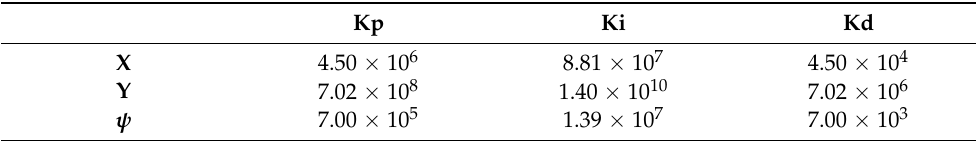
Table 2. Nonlinear Proportional Integral derivative (PID) control gains.